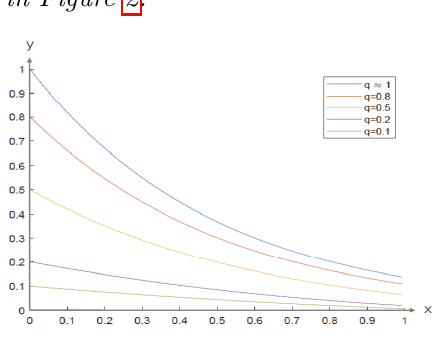
Figure 2. Behaviour of the response for various q values in Example